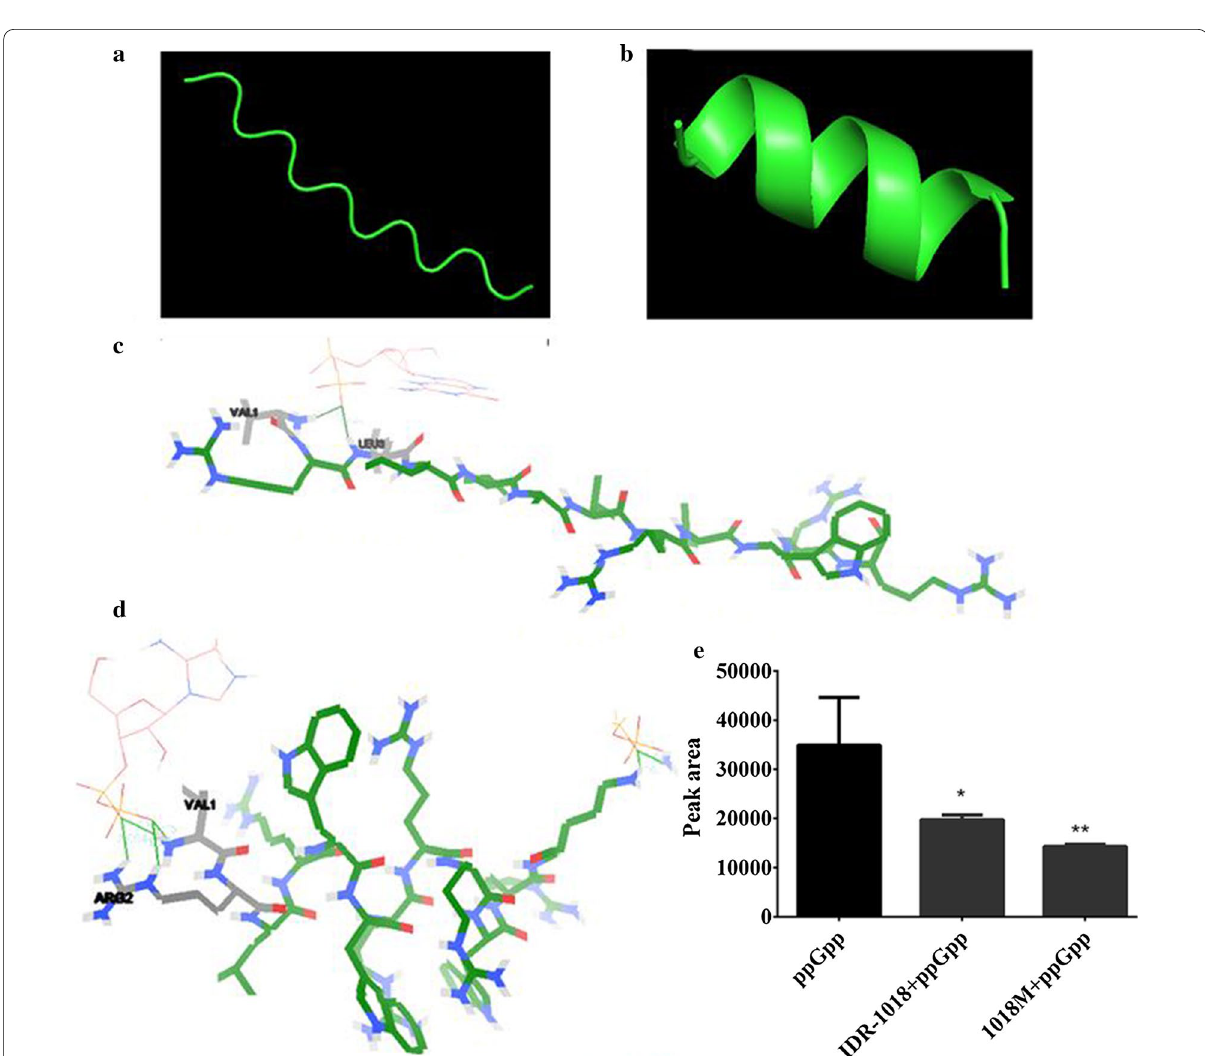
Fig. 1 Predictions of 1018M tertiary structures and binding affinity of 1018M with ppGpp. a , b Predictions of IDR-1018 ( a ) and 1018M ( b ) tertiary structures. c , d Molecular docking of IDR-1018 ( c ) and 1018M ( d ) with ppGpp. e Binding affinity of IDR-1018 and 1018M with